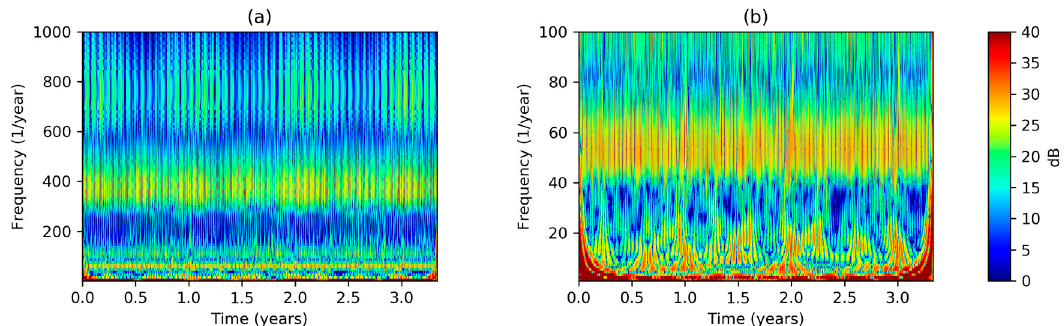
Figure 4. Electricity demand Wavelet Transform (scalogram): ( a ) Including high frequencies; ( b ) low frequency detail.